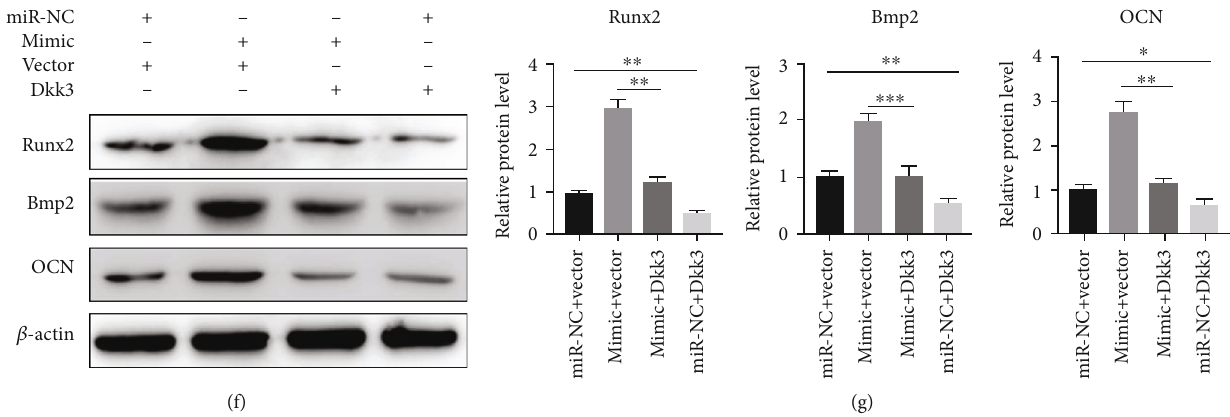
Figure 7: miR-129-5p regulated BMSC osteogenic di ff erentiation via repressing Dkk3. (a) pcDNA-Dkk3 or pcDNA-vector was transfected into BMSCs. The expression of Dkk3 was analyzed by western blot. (b) ALP and ARS staining of BMSCs following miR-129-5p mimic transduction or overexpression of Dkk3 during osteogenic di ff erentiation. (c, d) Absorbance index of ALP and ARS was calculated. mRNA (e) and protein (f) levels of osteoblast-related genes Runx2, Bmp2, and OCN were detected by quantitative RT-PCR and western blot, respectively. β -Actin was used as an internal control. (g) Semiquantitative analysis of protein expression levels of Runx2, Bmp2, and OCN. All data were expressed as means ± SD . ∗ p < 0 : 05 , ∗∗ p < 0 : 01 , and ∗∗∗ p < 0 : 001